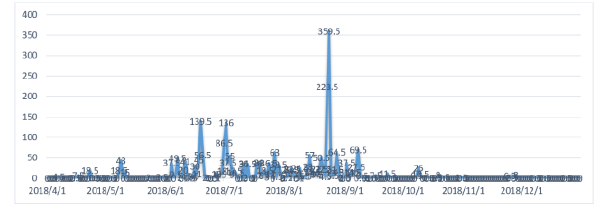
Figure 5. Daily precipitation during the study period